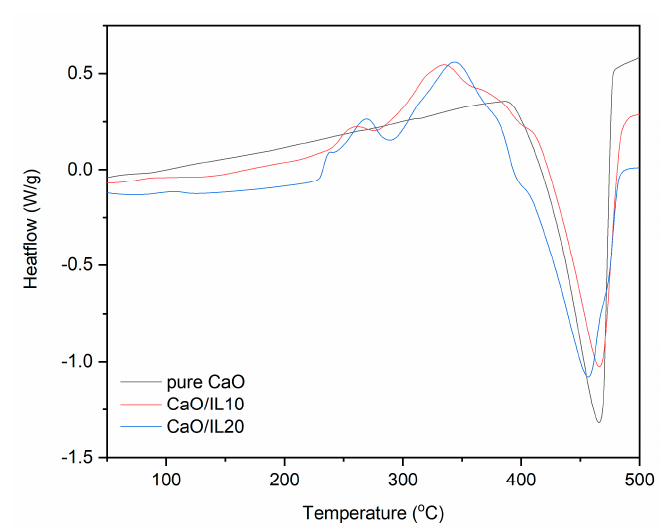
Figure 9. DSC curves for pure and DmiBr-modifed CB (exo^).